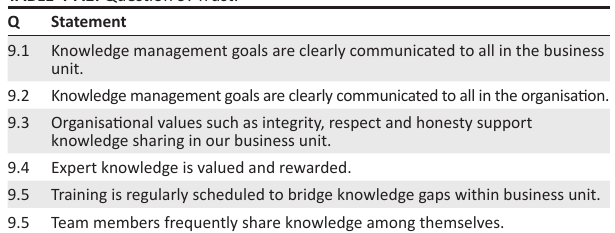
TABLE 4-A1: Question 9: Trust.